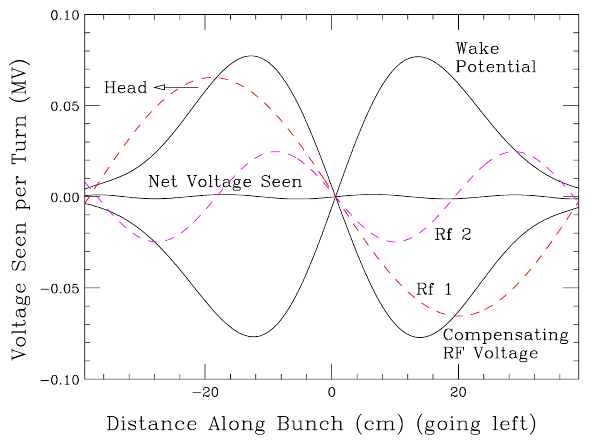
FIG. 4. (Color) Wake potential, compensating rf voltages, and net voltage seen by particles in the 13-cm bunch at injection. The compensating rf is the sum of two rf’s represented by red dashed lines and magenta dashed lines. sum of the compensation rf’s, which at injection are at